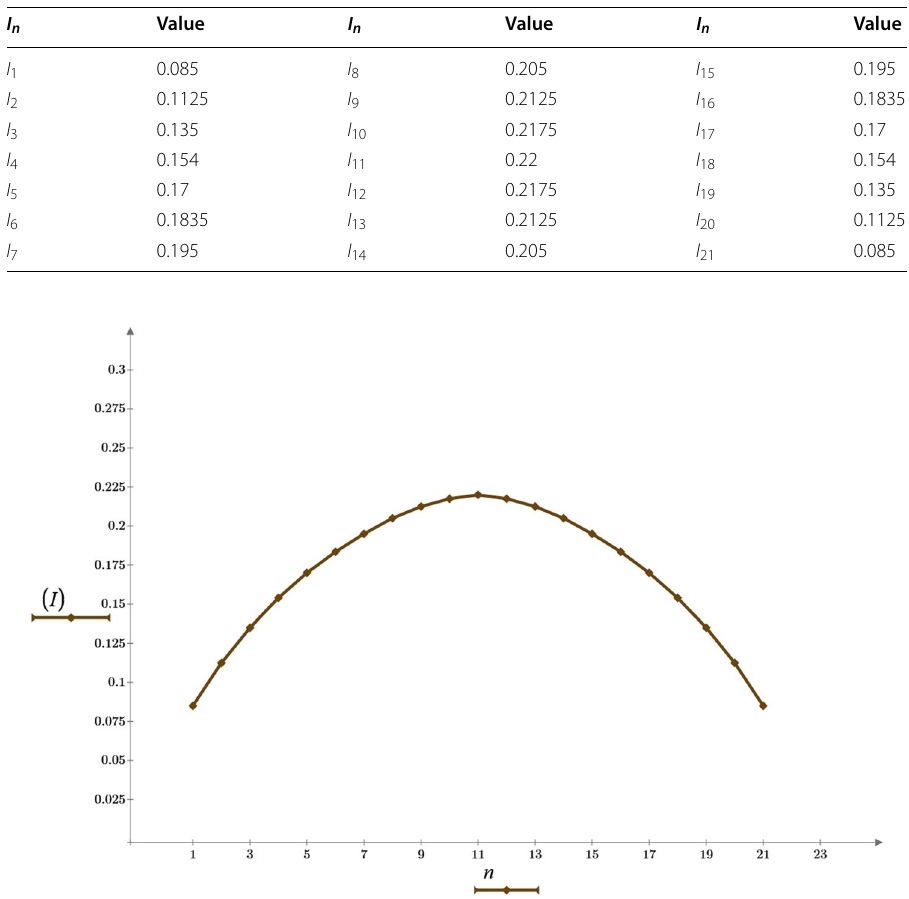
Fig. 3 A predetermined amplitude